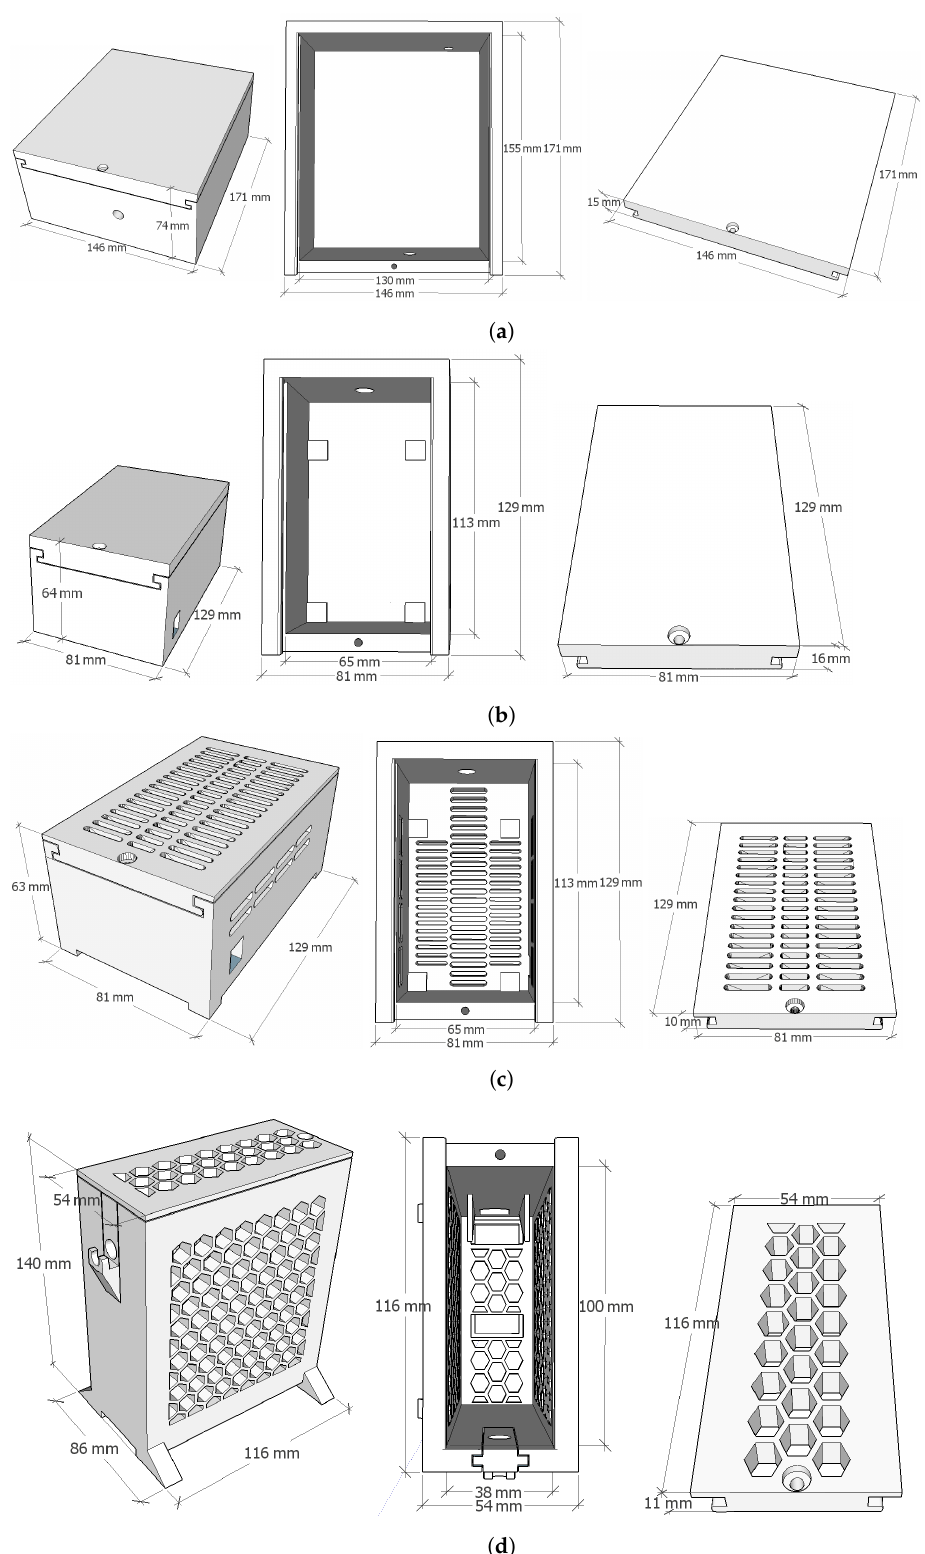
Figure 4. Boxes’ designs. Perspective view of the assembled box, top view of the base and perspective view of the cover. ( a ) Large Non-holed PLA box (LNP). ( b ) Small Non-holed PLA box (SNP). ( c ) Small Slot-holed PLA box (SSP). ( d ) Small Honeycomb-holed PLA box (SHP) or Small Honeycomb-holed TPU box